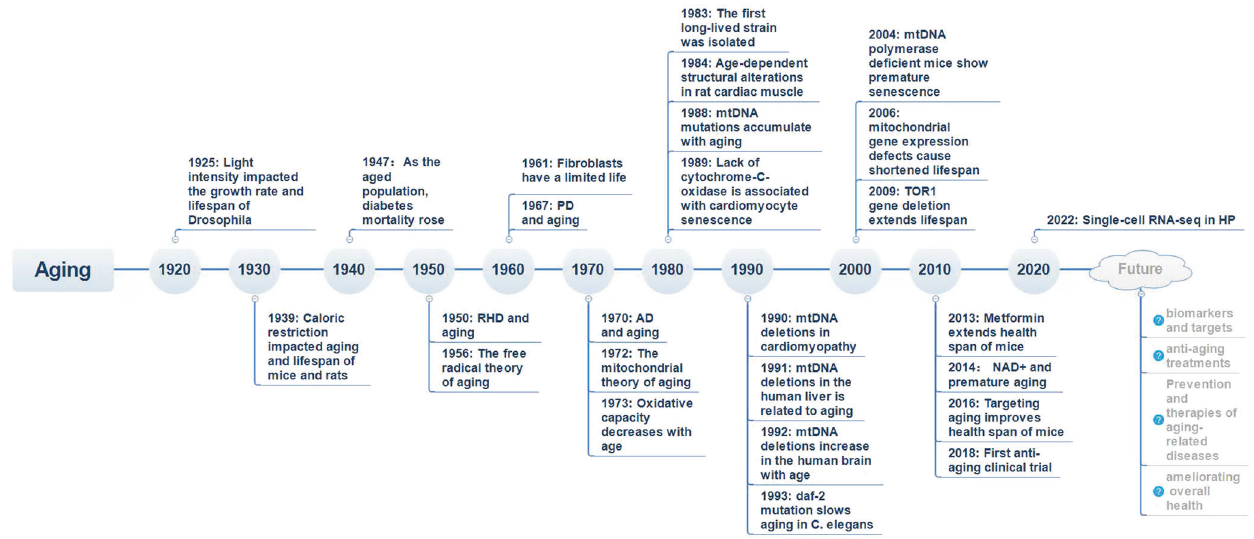
Fig. 1 Timeline of research on aging and aging-related diseases. RHD rheumatic heart disease, PD Parkinson ’ s disease, AD Alzheimer ’ s disease, mtDNA mitochondrial DNA, NAD + nicotinamide adenine dinucleotide, HP heterochronic